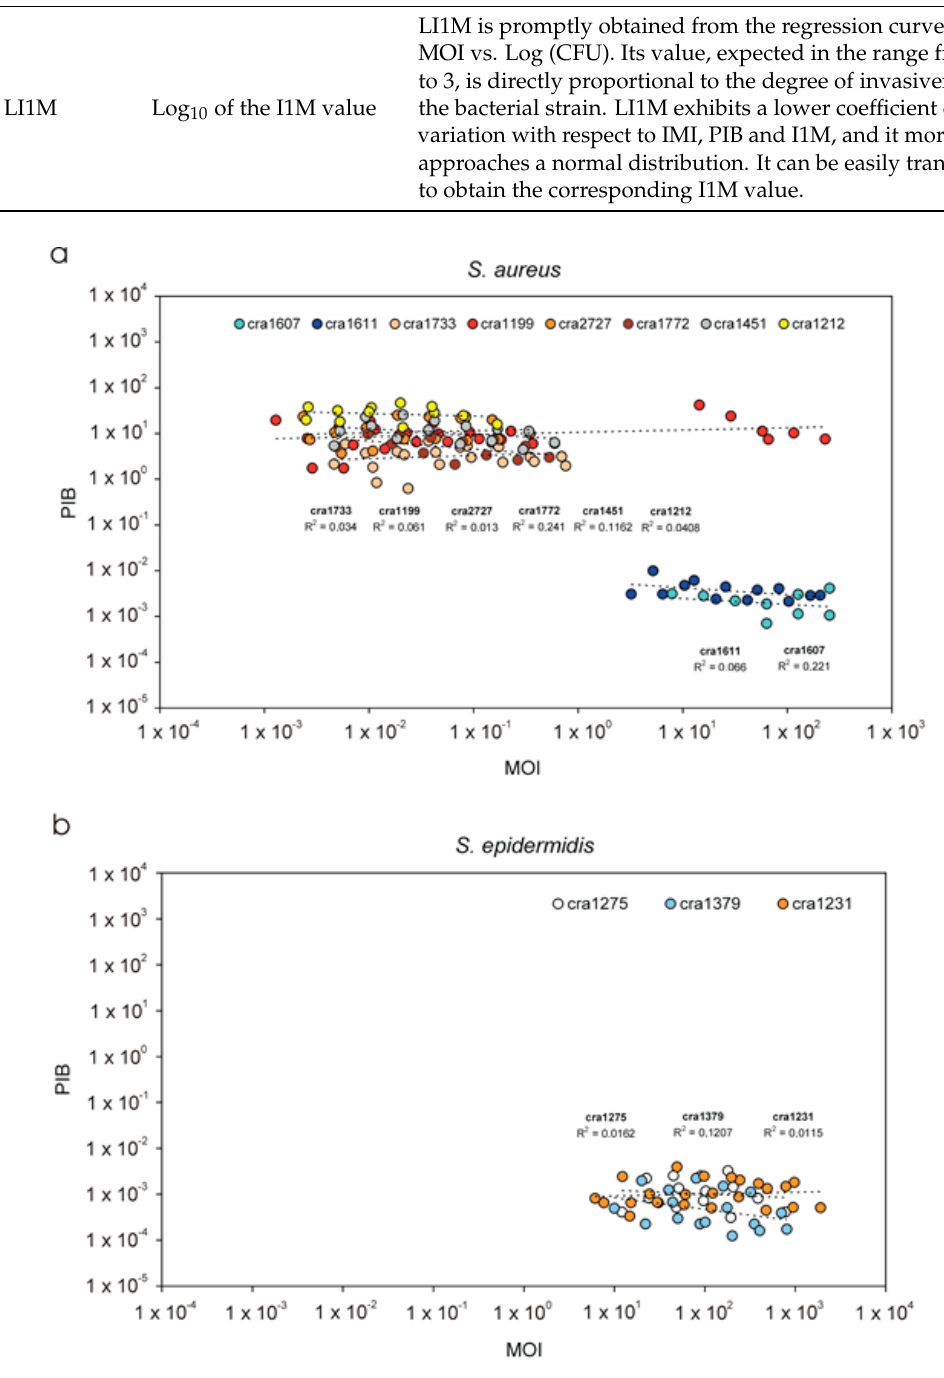
Figure 3. Variation of PIB (per cent of internalised bacteria) values obtained at different MOI (multiplicity of infection): ( a ) plot showing the distribution of each PIB value as a function of the inoculum size for all six S. aureus isolates; and ( b ) corresponding plot concerning three different S. epidermidis strains (those tested in three independent experiments). The R-square values of the PIB vs. MOI regression curve achieved for each single strain are reported in both graphs. It may be noticed as R-square values are generally very low and, in the broad range of MOI examined, any effect associated to the MOI appears negligible, especially in view of the large uncertainty of PIB measurements.